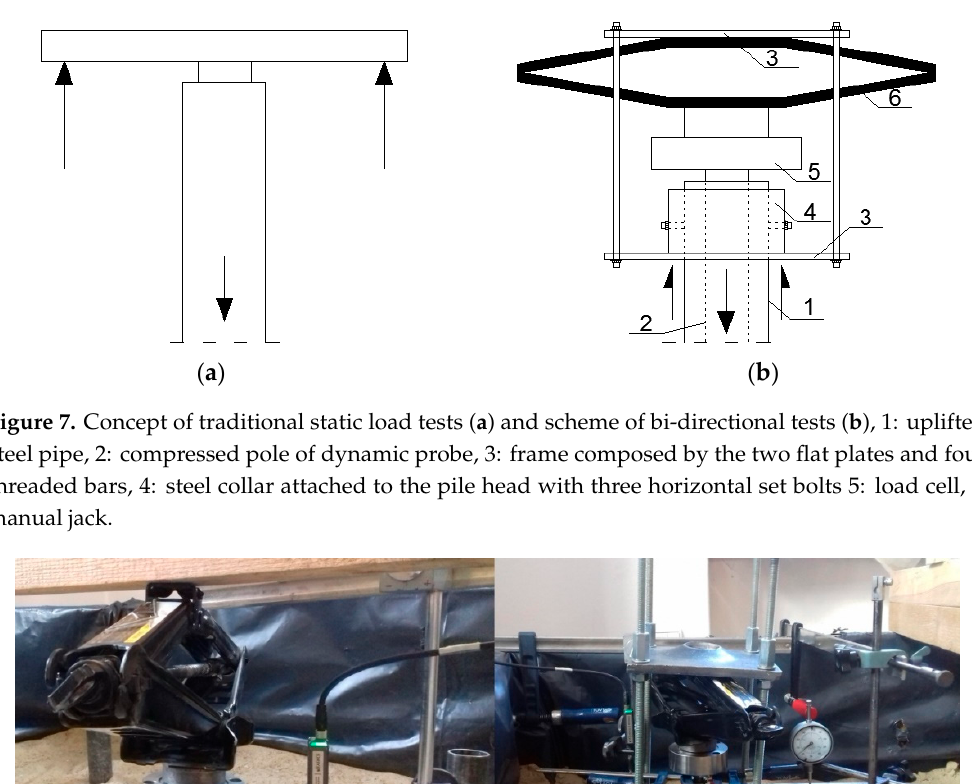
Figure 9. Example of pile head load and displacement vs. time plot for the traditional static load test.